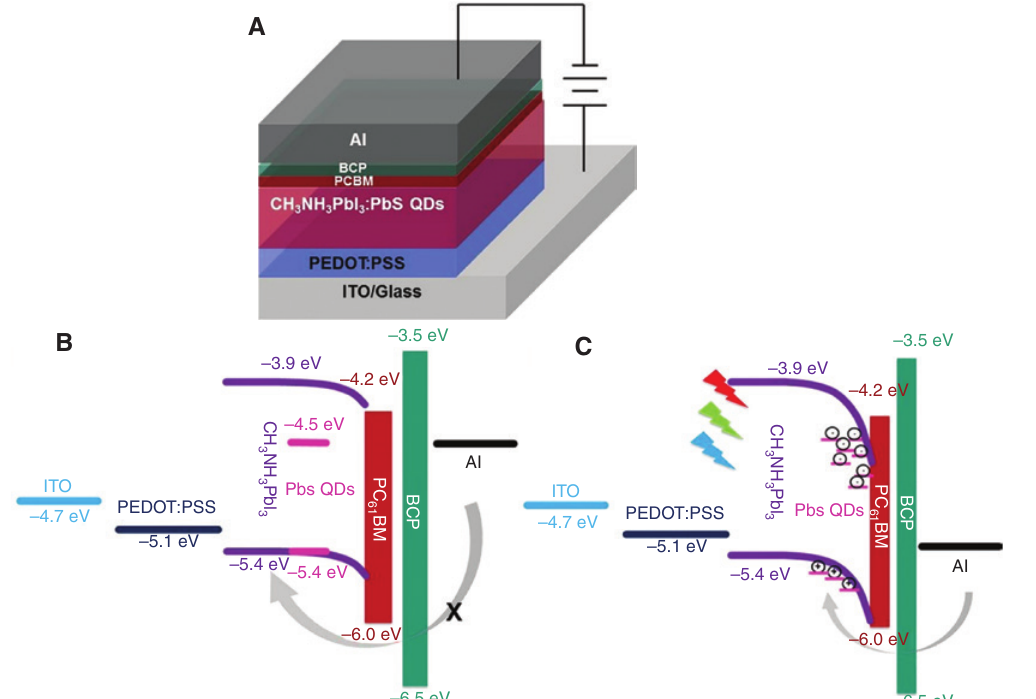
Figure 7: Device structure and proposed working mechanisms of perovskite hybrid PDs (pero-H PDs). (A) Device structure of pero-H PDs and energy level alignment of the materials used for the fabrication of pero-H PDs (B) in dark and (C) under illumination. Reproduced with permission from Ref.